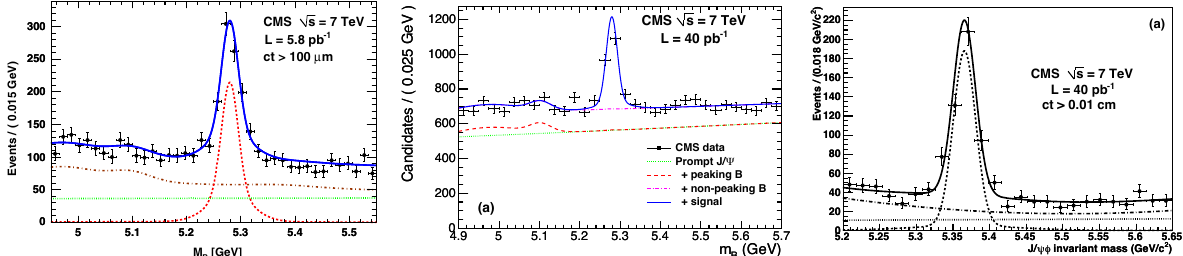
Fig. 1. Invariant mass distributions of the decays B + → J /ψ K + (left), B 0 → J /ψ K 0 are represented by the full dots. The solid lines are fits to the data.